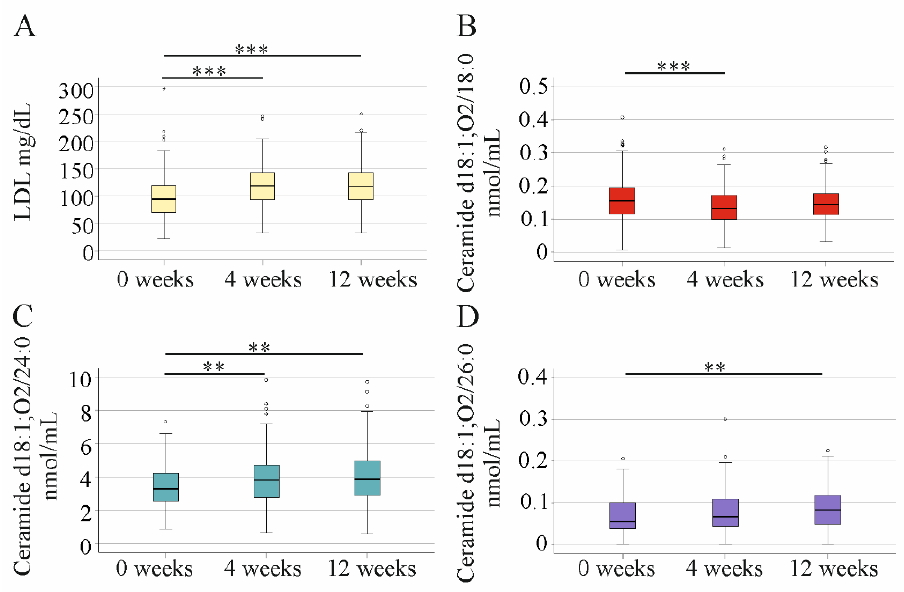
Figure 4. LDL and ceramide levels during the study. ( A ) LDL; ( B ) ceramide d18:1;O2/18:0; ( C ) ceramide d18:1;O2/24:0; and ( D ) ceramide d18:1;O2/26:0 before therapy (0 weeks; 178 patients) and at 4 weeks (178 patients) and 12 weeks (176 patients) after start of treatment. ** p < 0.01, *** p < 0.001.